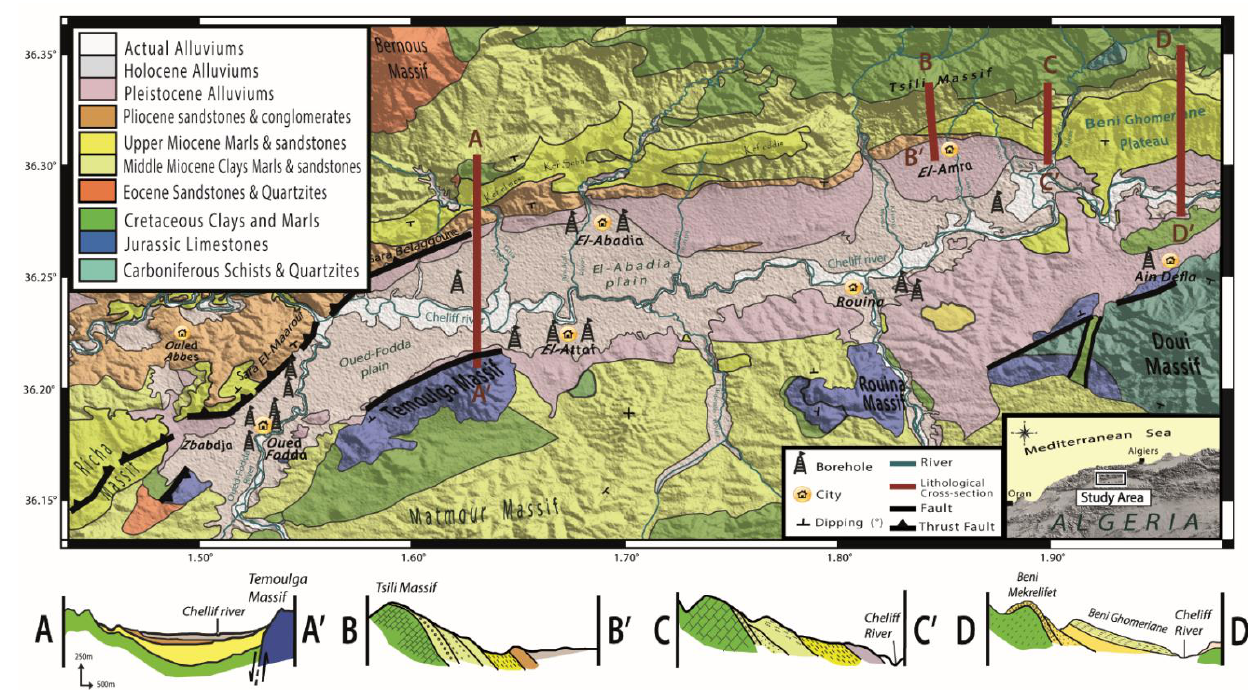
Figure 2. Geological map of the Middle-Chelif Basin. Modified and compiled from [33,36]. The lithological cross-section, AA’, is digitalized from [35]; BB’, CC’, and DD’ are from [32].